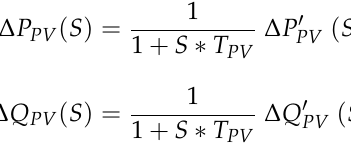
Figure 5. The block diagram of SPVS. 2.3. Modelling of BG The BG model is based on [22]. Figure 6a,b demonstrate the transfer function block diagrams of a real power generation model and a reactive power generation model. ( a ) ( b ) Figure 6. ( a ) Block diagram of real power generation of biogas and ( b ) block diagram of reactive power generation of biogas. The voltage regulation operation of the AVR (automatic voltage regulator) and ex ‐ citer is responsible for controlling reactive power in biogas (Figure 6). The equations for real and reactive powers are obtained and provided by considering the dynamic state after disregarding the saturation function: Δ(cid:1831) (cid:3044)(cid:3003)´ (cid:4666)(cid:1845)(cid:4667) (cid:3404)